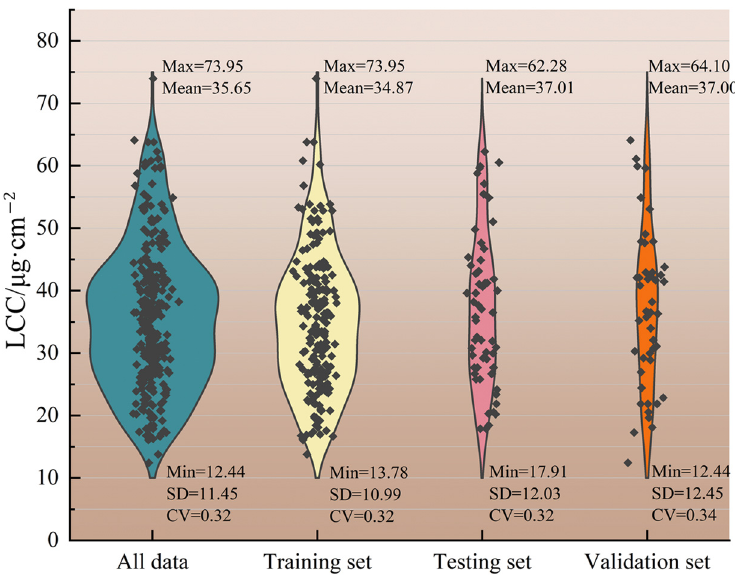
Figure 5. Statistical results of the litchi LCC for the training, testing, and validation datasets (SD: standard deviation, CV: coefficient of variation), the little dark gray dots in the diamond shape are the samples.